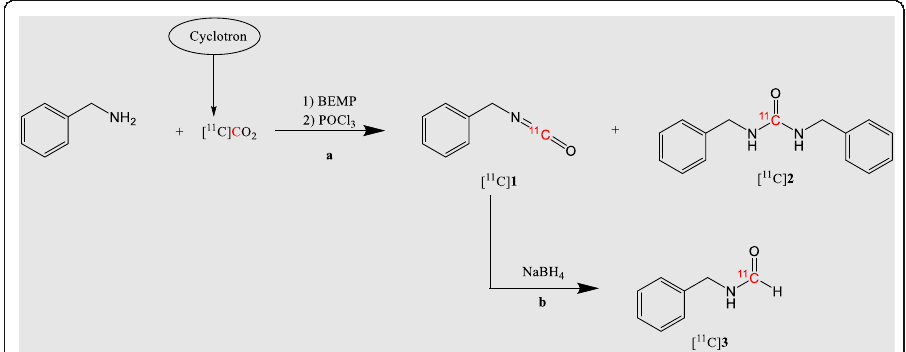
Scheme 1 Proposed reaction scheme for the one-pot synthesis of [ 11 C]formamides. Reaction conditions: a benzylamine (4.7 μ mol, 1 equiv.), BEMP (3.7 equiv.), diglyme (75 μ L), [ 11 C]CO 2 , 0 – 20 °C, 2 min, followed